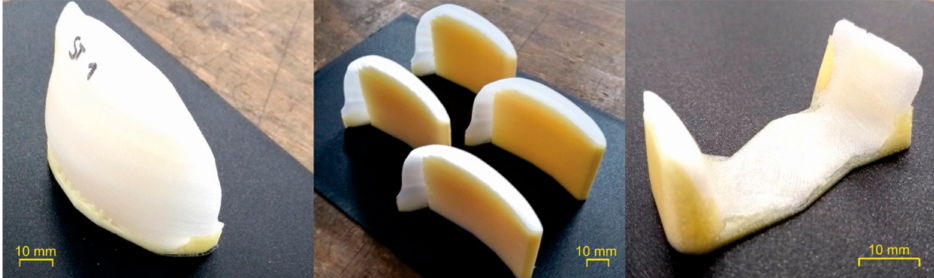
Figure 9. Benchmark “implants” printed with the optimized printing parameters (“PMMA final values” in Table